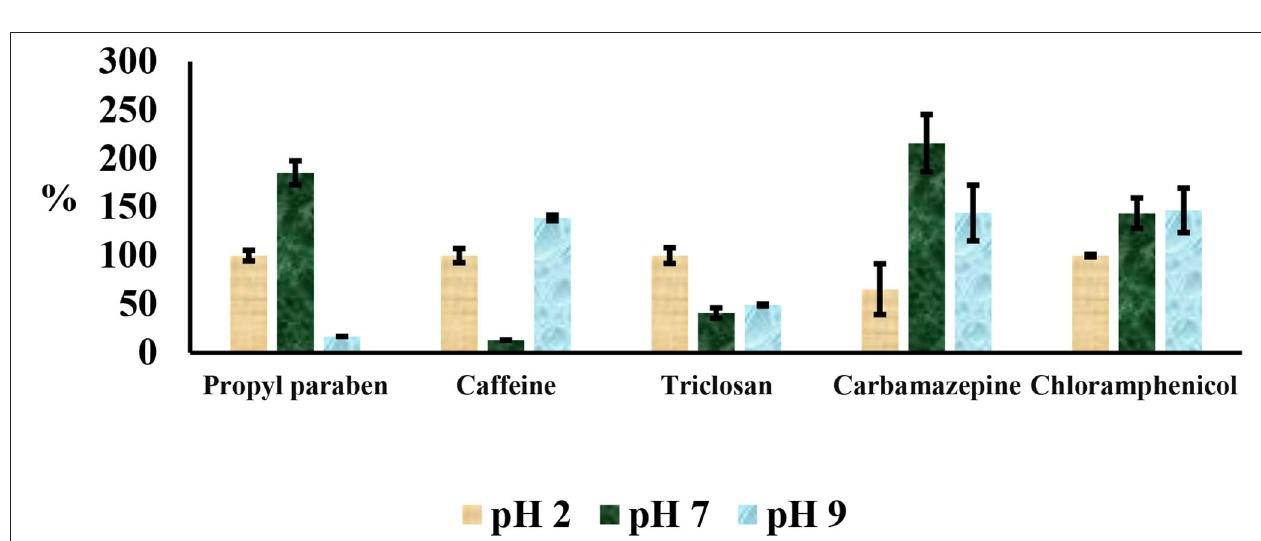
FIGURE 4 | Influence of pH in the water extraction and cleanup step.